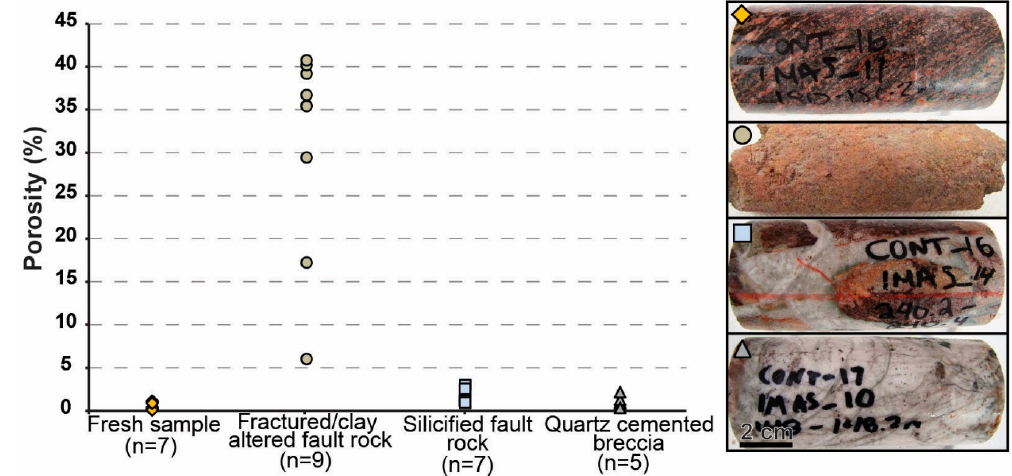
Figure 6. Porosity measured for fresh samples (granitic gneiss from the Contact prospect), pervasively silicified cataclastic fault rock, thick quartz veins within granitic gneiss, and clay-altered, fractured host rock (examples for each category are displayed on the right of the chart).